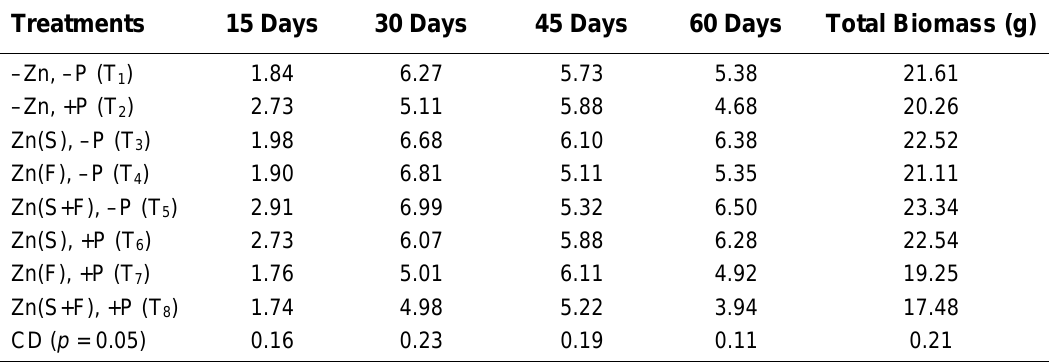
Interaction Effect Between Zn and P on the Fresh Biomass Yield (g) of Stevia Plant ( S. rebaudiana ) (Mean of Four Replications)